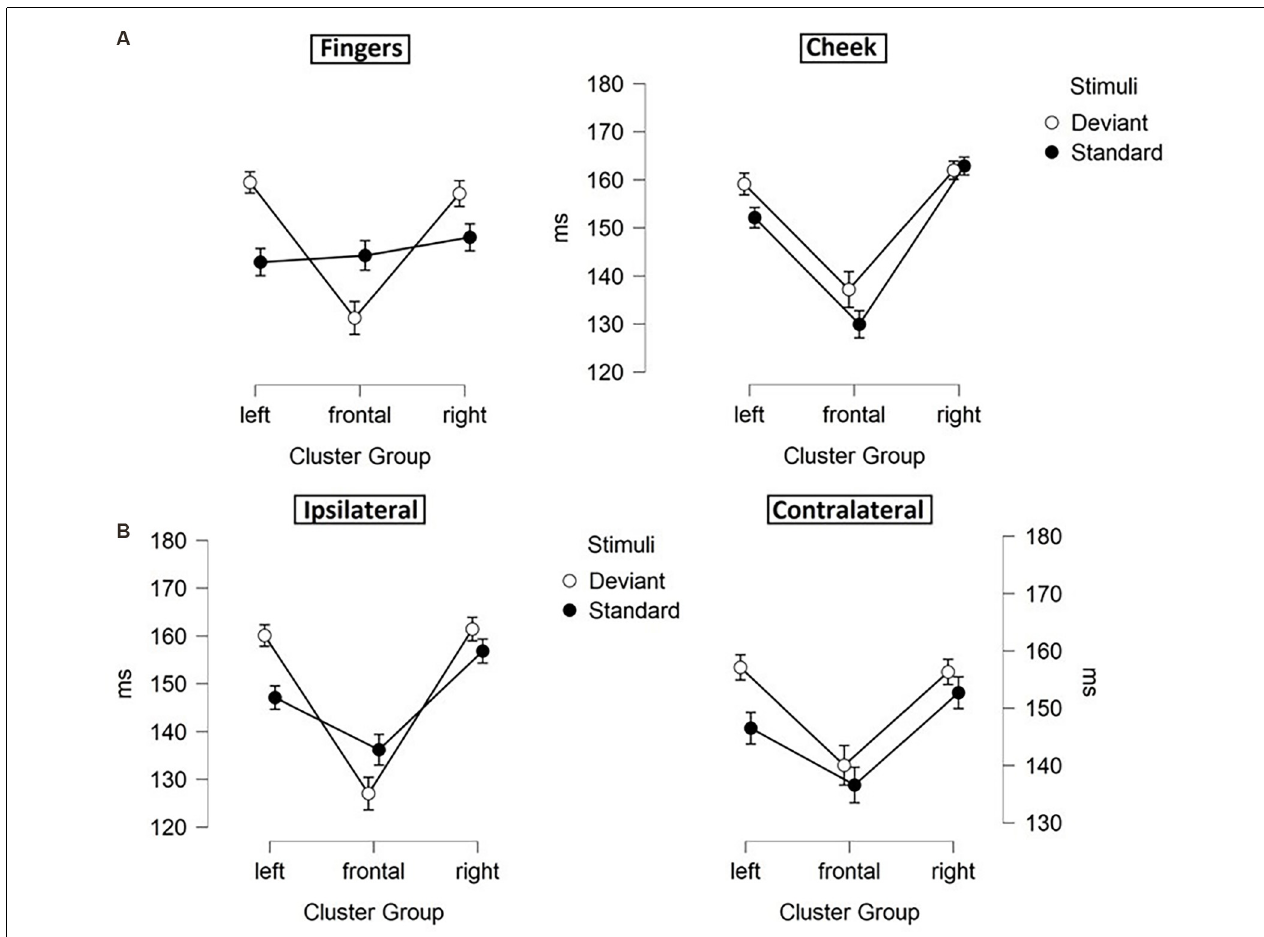
FIGURE 6 | Mean values (ms) of N140 latencies with SE. Three-way-interactions: (A) Cluster Group x Body Part x Stimuli, (B) Cluster Group x Laterality x